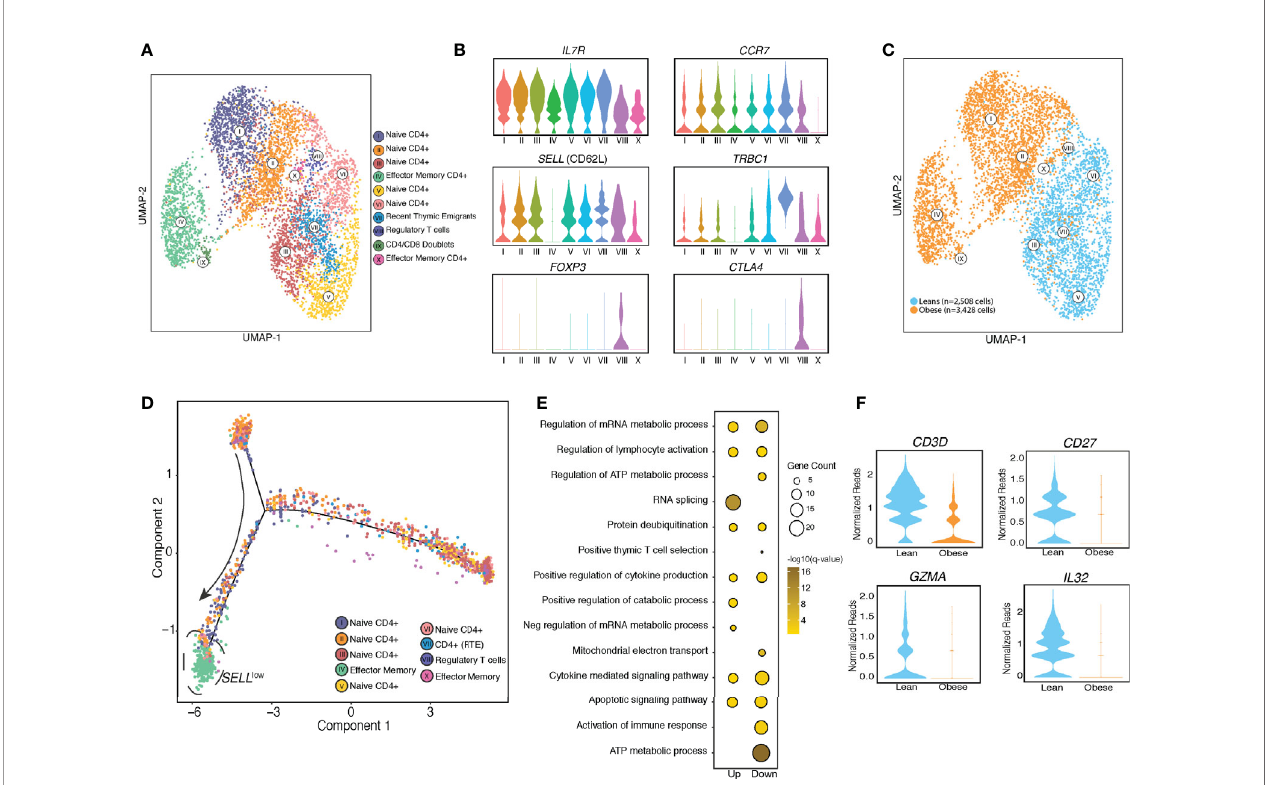
FIGURE 2 | UCB CD4 T cells from babies born to mothers have distinct resting transcriptional pro fi les. (A) UMAP visualization of CD4 T cells clusters from UCBMC single cell pro fi les of babies born to lean (n=2) and mothers with obesity (n=2) colored by cell state. (B) Violin plots of canonical T cell markers associated with naïve T cells, activated T cells, recent thymic emigrants (RTE) and regulatory T cells. (C) UMAP visualization of CD4 T cell clusters colored by phenotype – leans colored in blue and obese in orange. (D) Trajectory analysis of CD4 T cells, colored by clustered and ordered by pseudotime based on differentially expressed genes identi fi ed by monocle. (E) Bubble plot representing gene ontology terms enriched from differentially expressed genes (DEG) identi fi ed in naïve T cell clusters in obese group relative to the lean group. Size of the bubble represents the number of genes mapping to the term while color indicates level of signi fi cance. (F) Violin plot showing normalized expression levels of genes downregulated in naïve cord blood CD4+ T cells with maternal